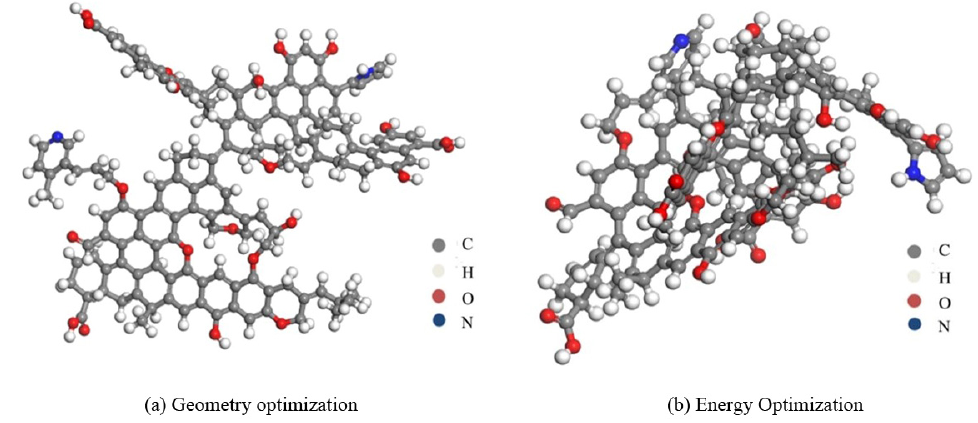
Figure 5. Three-dimensional model of Kerjian coal molecule ( a : Geometry optimized model, b : Energy optimized model). Table 7. Energy changes of structural optimization of Kerjian coal